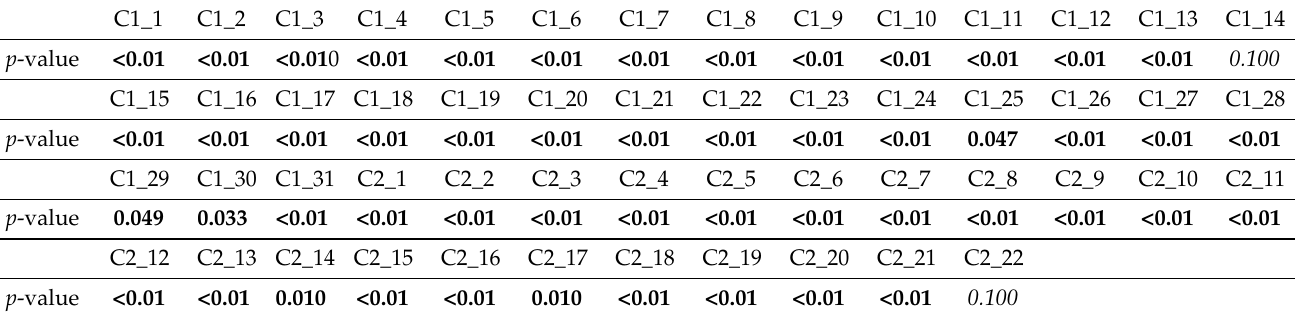
Table 4. p -values obtained for the KPSS